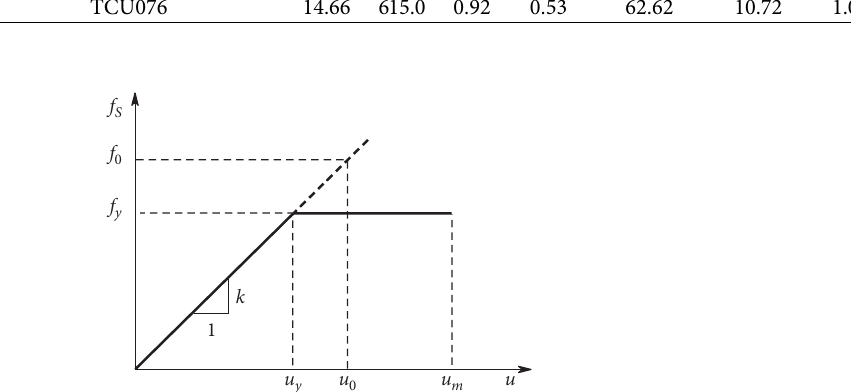
Figure 2: Force-deformation relationship of an elastoplastic single-degree-of-freedom system and the corresponding elastic